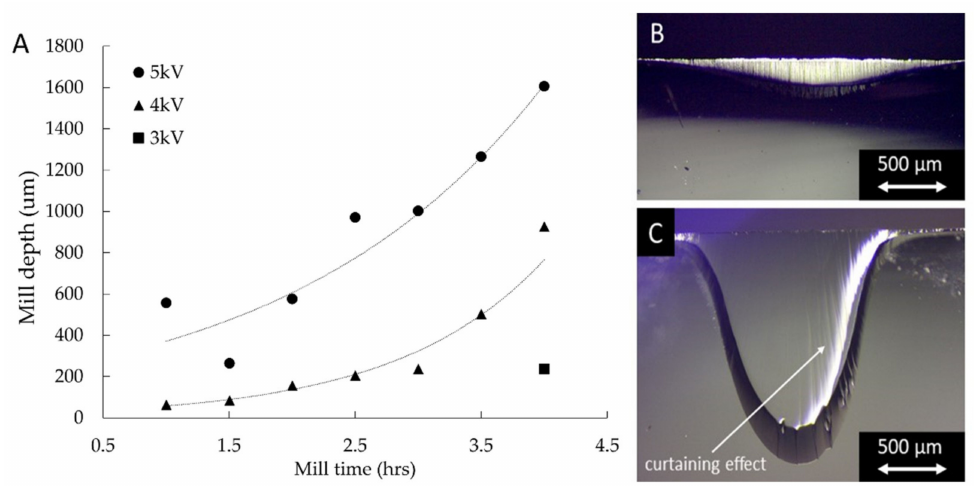
Figure 3. ( A ) Effect of ion beam source accelerating voltage and milling time vs. mill depth. The inserts show optical microscope images of the side view of a sample milled ( B ) at 4 kV for 1.5 h and ( C ) at 5 kV for 3.5 h (both are reported in ( A